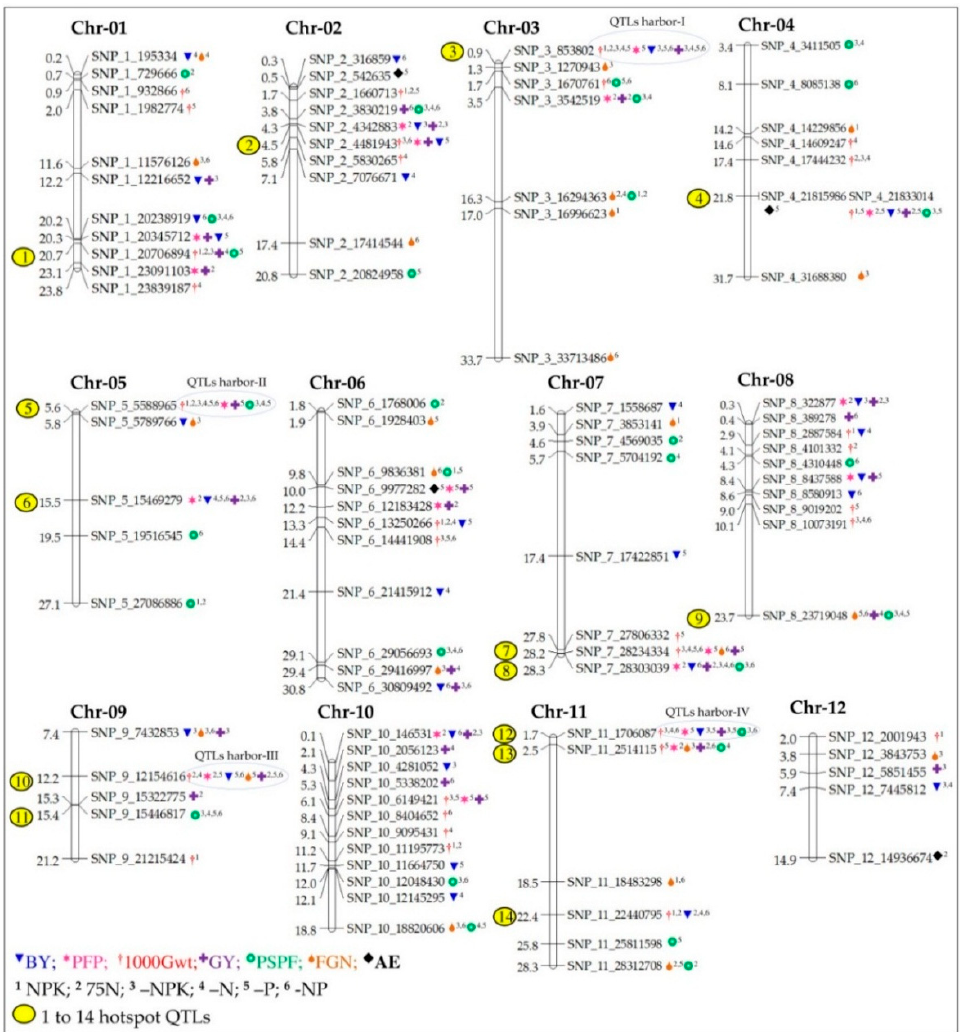
Figure 3. Linkage map of 261 QTLs distributed on 12 chromosomes, with respective polymorphic markers and colors depicting the QTLs governing crucial different nutrient traits.